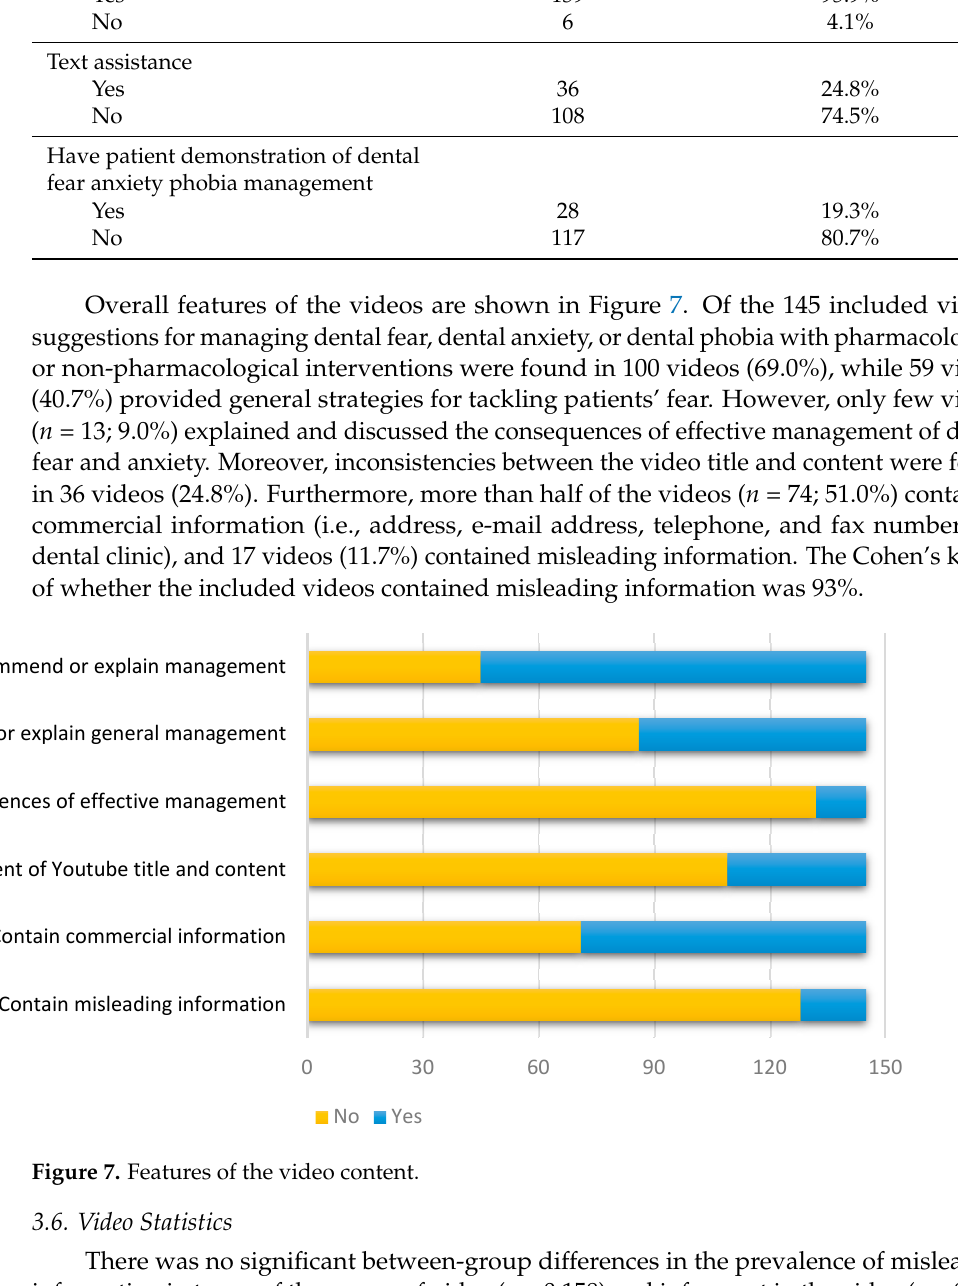
Table 11. Proportion (%) of videos with misleading information according to different video fea- tures.